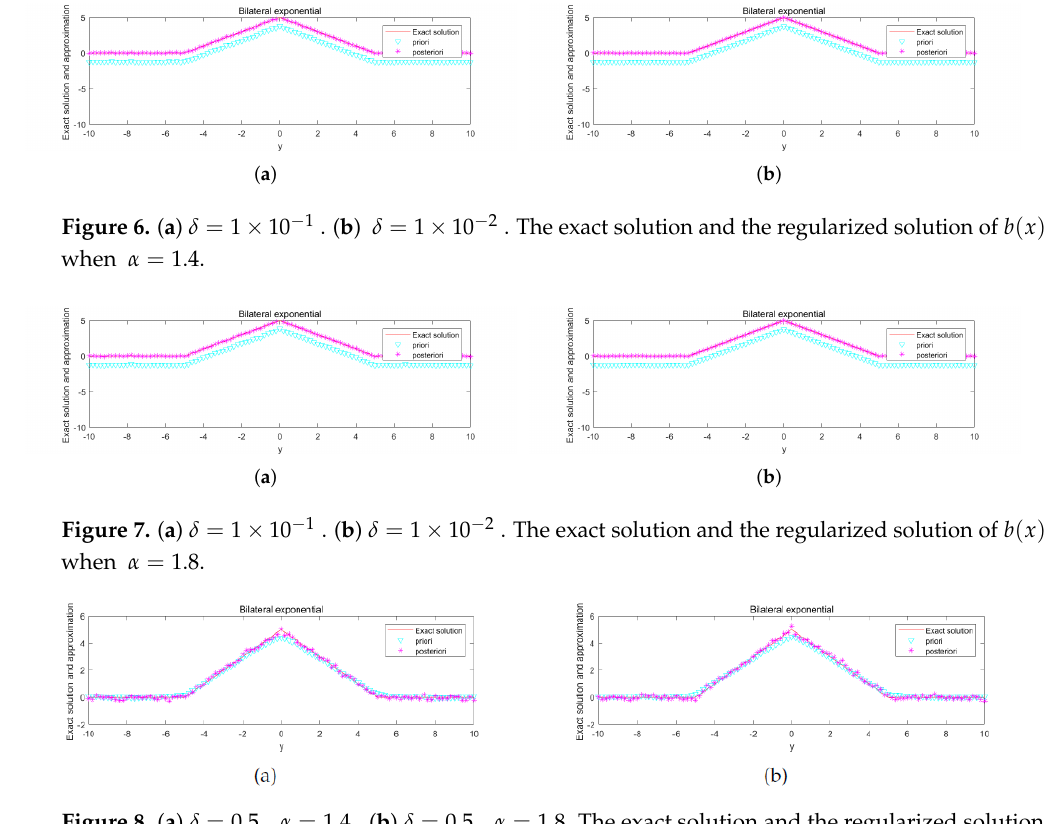
Figure 8. ( a ) δ = 0.5, α = 1.4 . ( b ) δ = 0.5, α = 1.8. The exact solution and the regularized solution of f ( x ) .